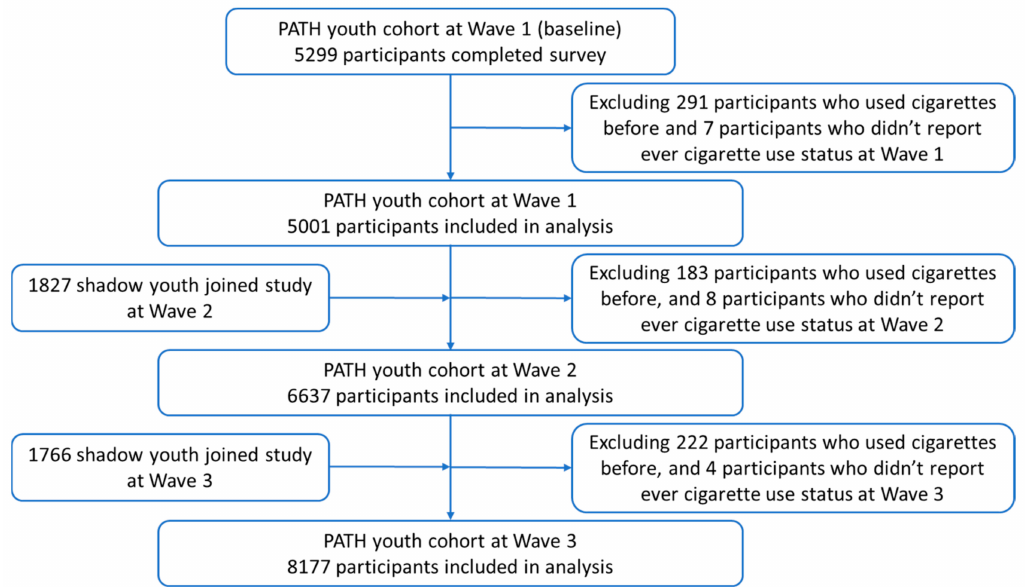
Figure 1. Flowchart for participants included in final